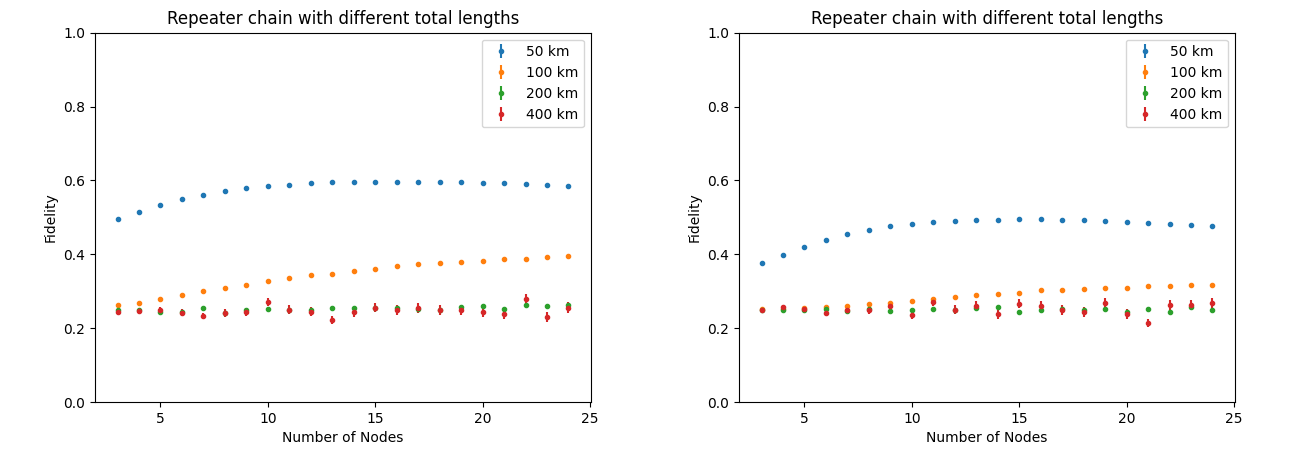
Figure 6. Fidelity vs. number of nodes, for different total lengths; ( left ) p di = 0.006, p dl = 0.015; ( right ) p di = 0.012, p dl = 0.025. In both cases, T 1 = 2.68 ms and T 2 = 1 ms. No purification is